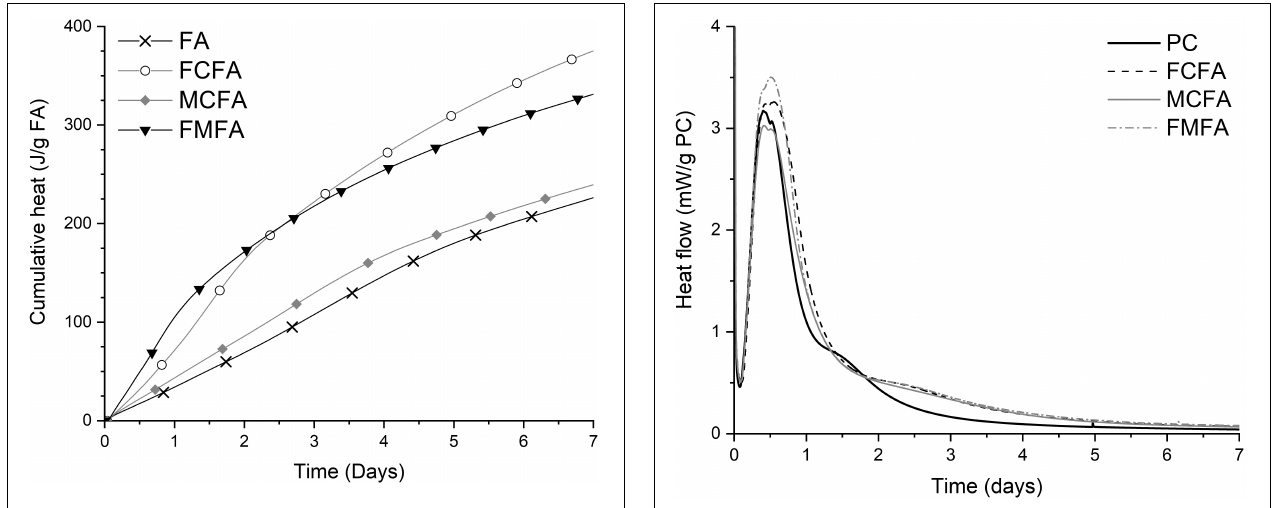
FIGURE 3 | Hydration heat flow results of the fly ash blended cements and the control Portland cement, values are expressed as J/g of Portland